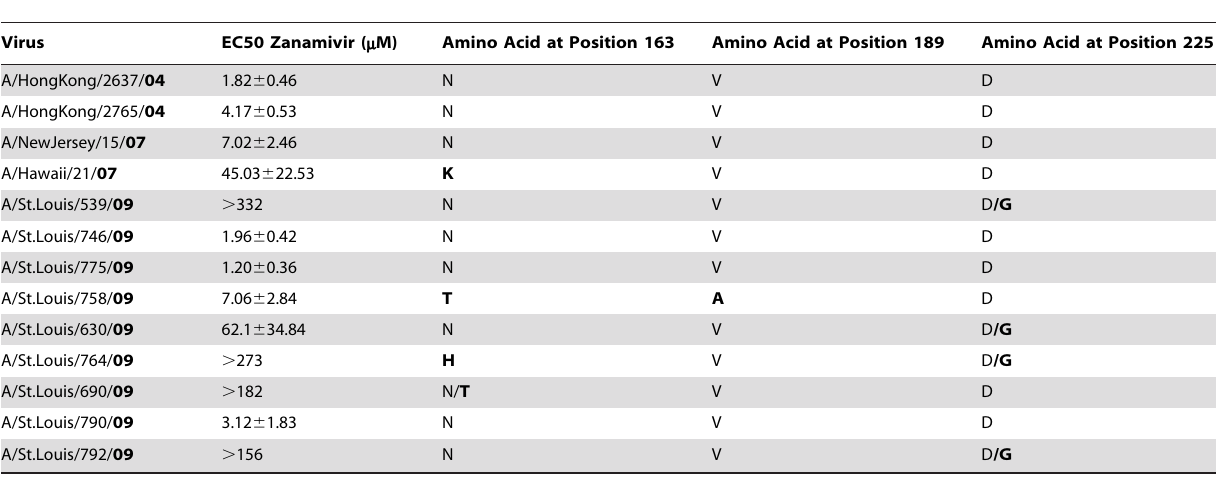
Table 3. Hemagglutinin (HA1) mutations specific to isolates with reduced zanamivir sensitivity.